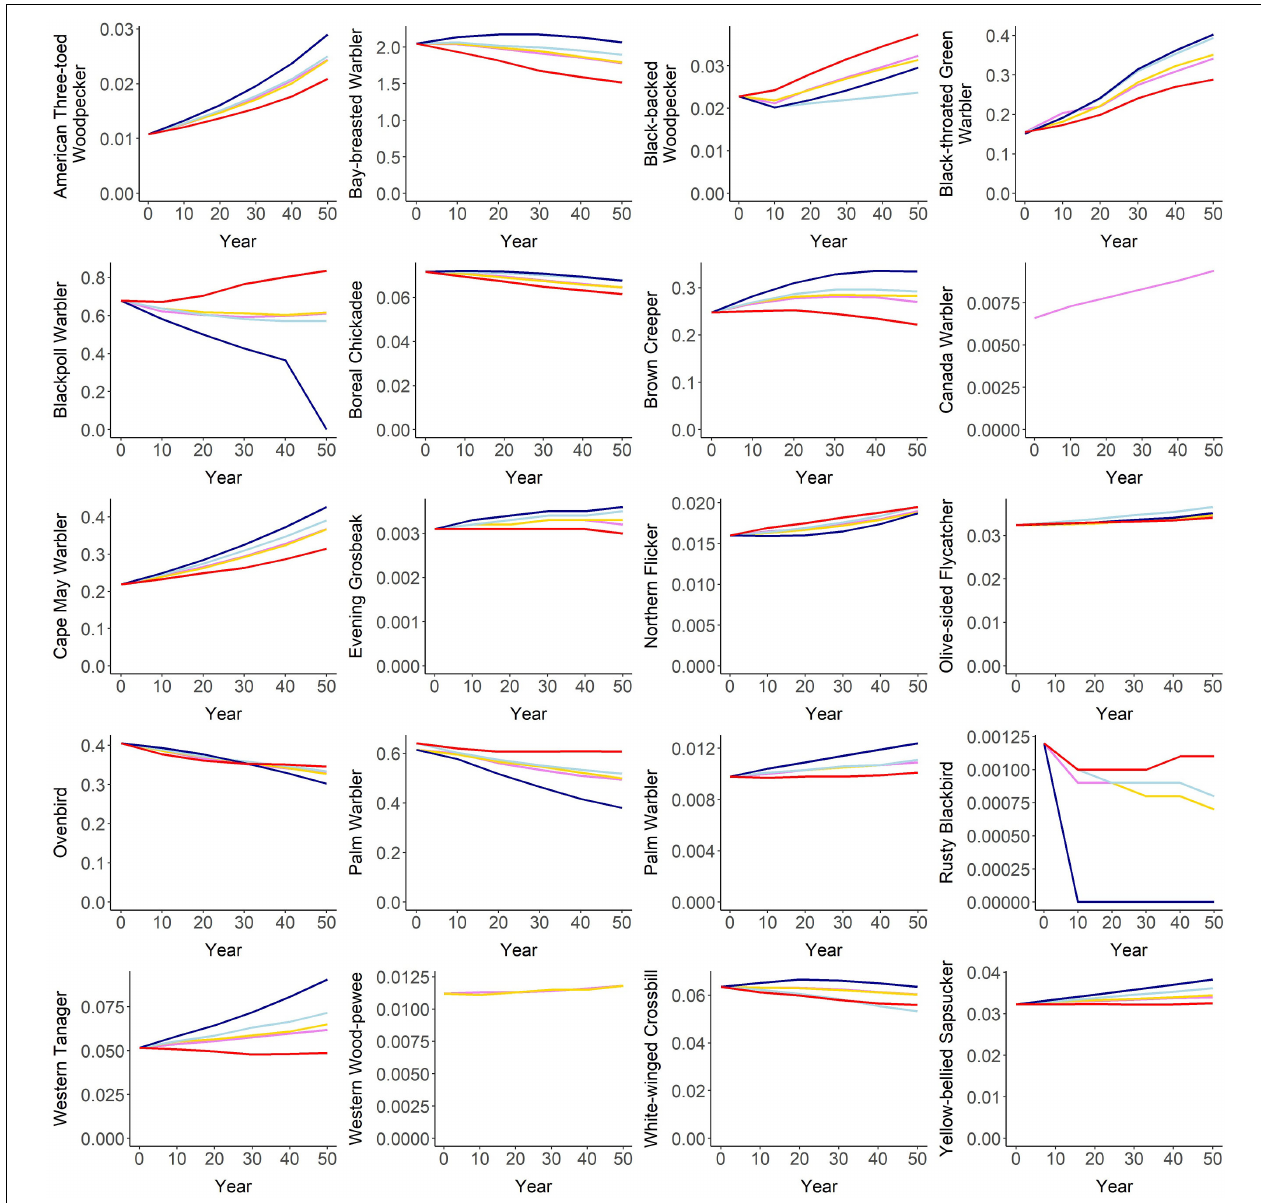
FIGURE 10 | Projected mean density (# males/ha) of 20 species in the Al-Pac Forest Management Area (FMA) over 50 years under 5 land use scenarios. Projected population size can be calculated by multiplying mean density by the number of hectares in the Al-Pac FMA (6,563,755). All scenarios share the same amount and locations of harvest disturbances. “Al-Pac BAU” (violet line) assumes that some forest habitat is either set back by fire or converted to other land uses by energy sector development but also by agriculture and urbanization. “Seismic Restoration” (gold line) assumes the same amount and location of fire, harvest, and non-forestry footprint as “Al-Pac BAU,” but also assumes that seismic lines are successfully reclaimed and start regenerating to forests. “No Fire” (dark blue line) assumes that no future forests are burned by fire, but levels of conversion to non-forest habitats are the same as in “Al-Pac BAU”. “No Energy” (light blue line) assumes that no new energy sector development occurs, but levels of fire and conversion to other non-forest habitats are the same as in “Al-Pac BAU.” “Increased Fire” (red line) assumes that the same amount of forest habitat is converted to other land uses like energy sector development, agriculture, and urbanization as “Al-Pac BAU,” but twice the amount of forest is burned each decade, reducing older forests relative to “Al-Pac BAU”. Generally as the amount of simulated disturbance increases from least (“No Energy,” “No Fire”) to most (“Increased Fire), species associated with older forests are more likely to decline or less likely to increase, while species associated with younger or mature forests are more likely to increase or less likely to